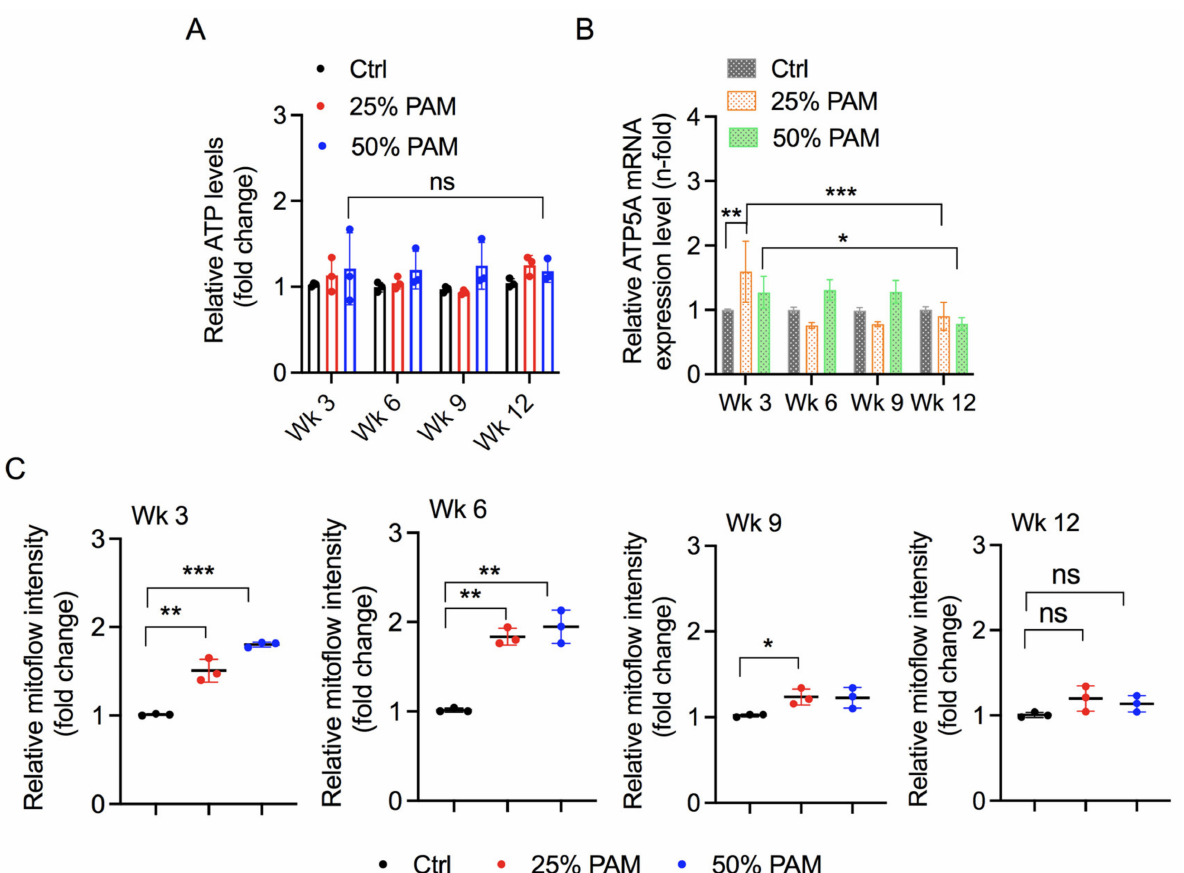
Figure 4. Effect of periodic PAM exposure on cellular energetics. ( A ) ATP levels in fibroblast cells were exposed periodically to PAM. Statistical significance was evaluated using Dunnett’s multiple comparison test with two-way ANOVA analysis. ( B ) mRNA levels of ATP5A gene. Statistical significance was evaluated using Dunnett’s or Tukey’s multiple comparison test with two-way ANOVA analysis. ( C ) Mitoflow intensity levels in fibroblast after periodic PAM exposure across weeks (Wk). Statistical significance was evaluated using Dunnett’s multiple comparison test with one-way ANOVA and is indicated as * p < 0.05, ** p < 0.01, and *** p <